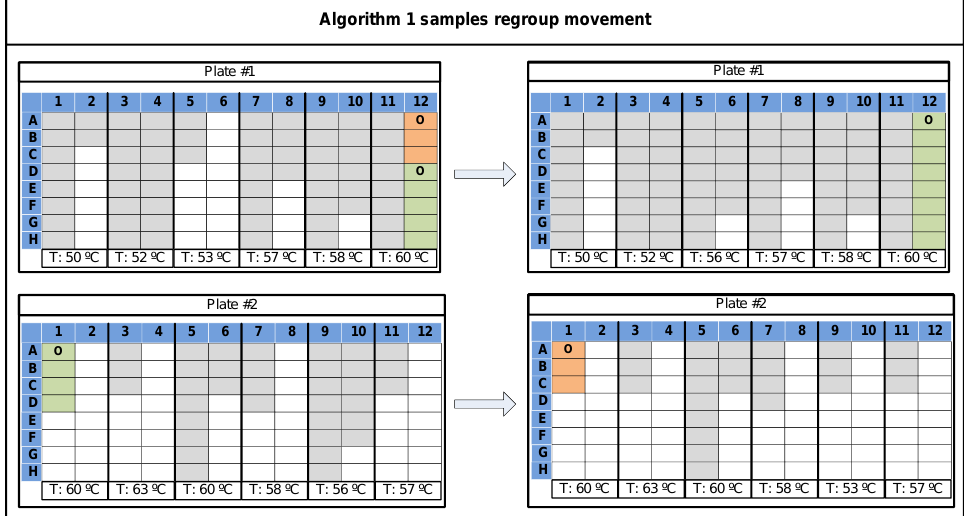
Figure 3. Algorithm 1 regrouped samples movement